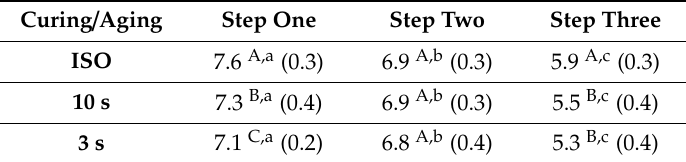
Table 2. Three-point bending test: mean flexural modulus E f in MPa (mean and standard deviation). Superscript letters indicate homogeneous groups; Capital letters indicate sub-groups related to columns; Lowercase letters indicate sub-groups related to rows; Tukey’s post-hoc test ( α =